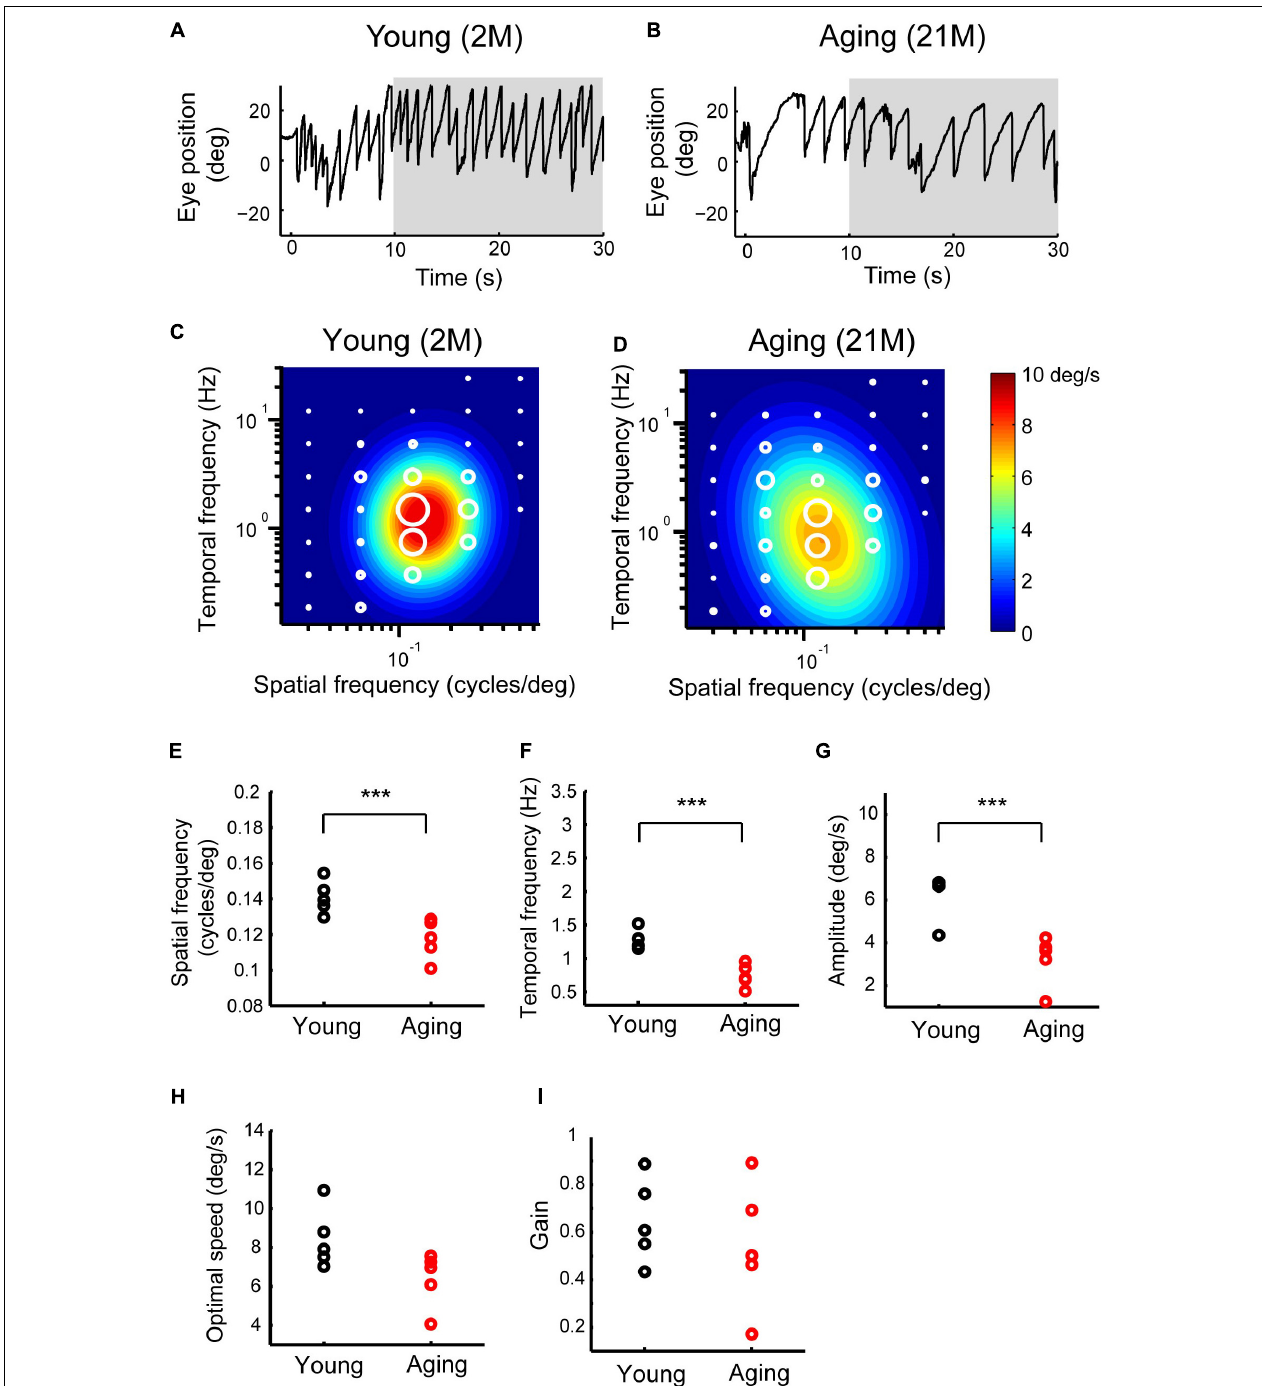
FIGURE 6 | Late OKRs in the young adult and normal aging mice. (A,B) Eye position profiles during OKNs in a young adult mouse (A) and in an aging mouse (B) . Mice were exposed against a moving sinusoidal grating patterns (T-N direction spatial frequency 0.125 cycles/deg, temporal frequency 1.5 Hz, contrast 64%) for 30 s. Slow phase eye velocities during 20-s intervals starting 10 s after the onset of visual motion averaged for each stimulus condition (gray shaded area). (C,D) Heat maps of the late OKRs in the young adult mice (2–3 months old, n = 5) (C) and normal aging mice (21–24 months old, n = 5) (D) . Mean amplitudes of the slow-phase eye velocity of the late OKRs represented by diameter of the white circles are plotted in the coordinate system of SF and TF. Heat maps indicate the best-fit Gaussian functions (C,D) . Comparisons of the properties of the late-phase OKRs. The differences in the optimal SF (E) , optimal TF (F) , peak amplitudes of the responses (G) , stimulus speed at the optimal spatiotemporal frequency (H) , and gain at optimal stimuli (I) are shown in individual plots (black dots: young adult, red dots: aging). *** p = 7.9 × 10 - 3 , Wilcoxon rank-sum test.